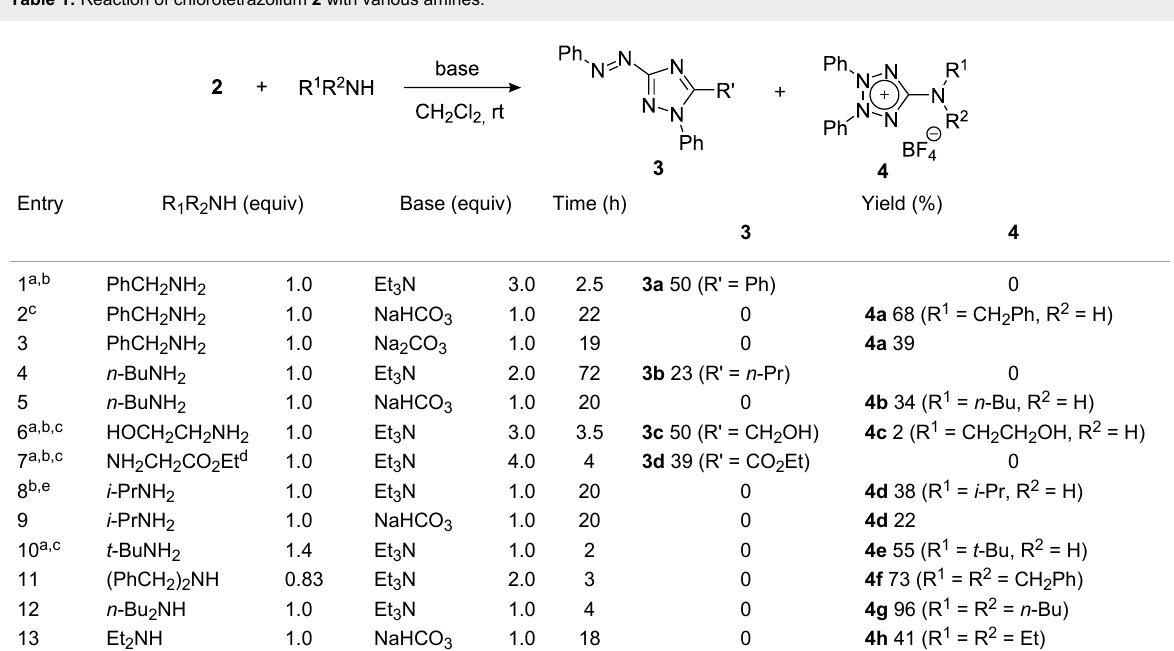
Table 1: Reaction of chlorotetrazolium 2 with various